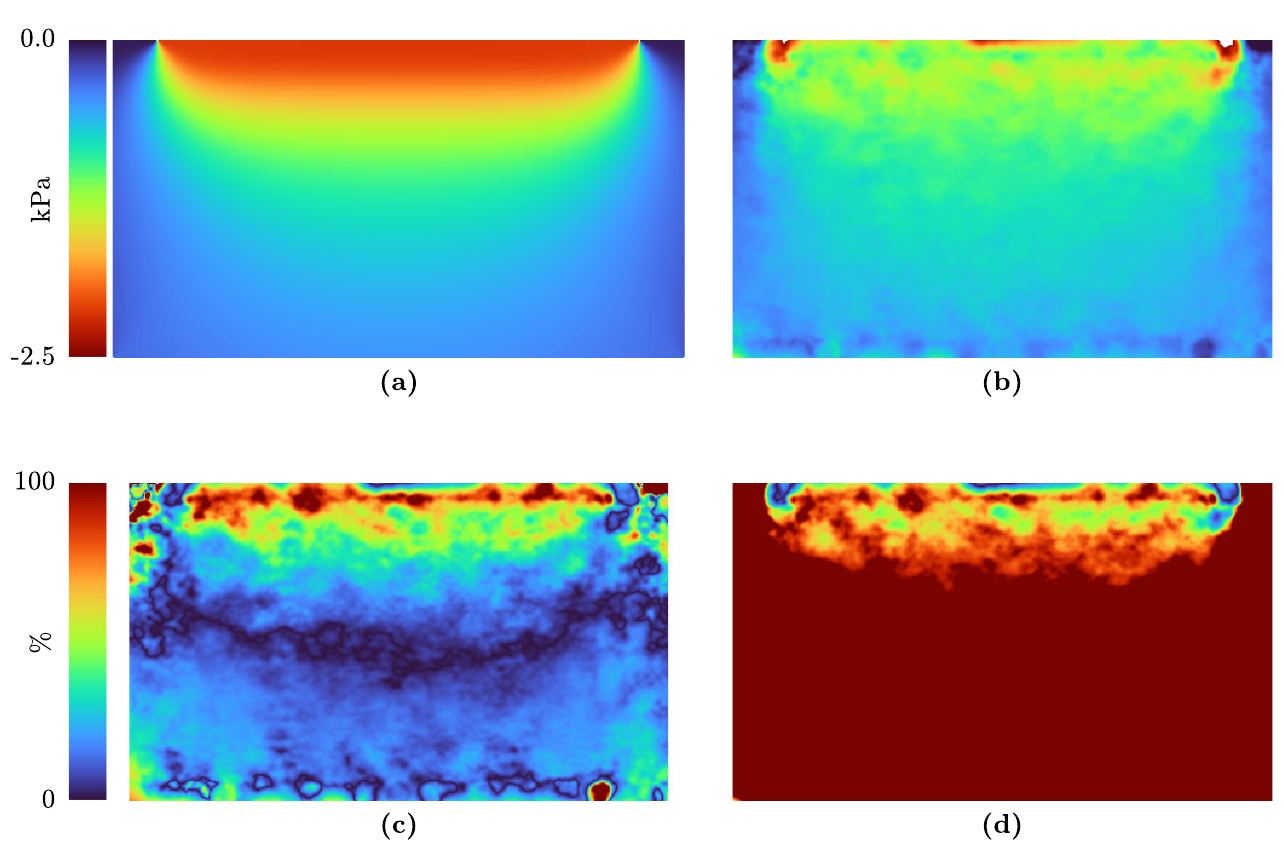
Figure 9. Stress field in a homogeneous specimen under compression of 635Pa with a transducer width and depth of 38mm and 8mm, respectively. The stress in the image plane, which is shown in Figure 8, is displayed: ( a ) Stress field σ zz calculated with Love’s solution; ( b ) Stress field σ zz estimated by FEBio, further considered to be the true stress distribution; ( c ) Relative error of the stress field estimated by Love’s solution, compared to the results of FEBio; ( d ) Relative error of the stress field with the plane–stress assumption, compared to the results of